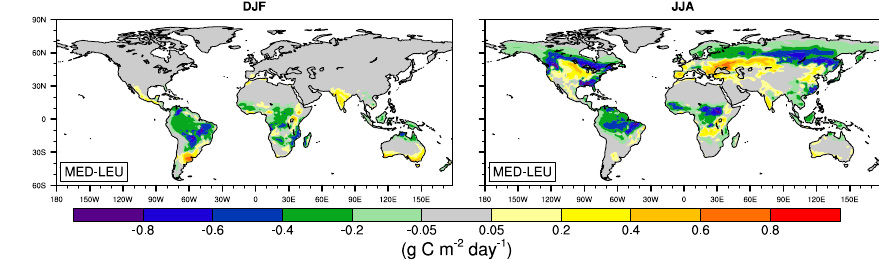
Figure 8. Mean seasonal difference in net primary productivity between the MED and LEU